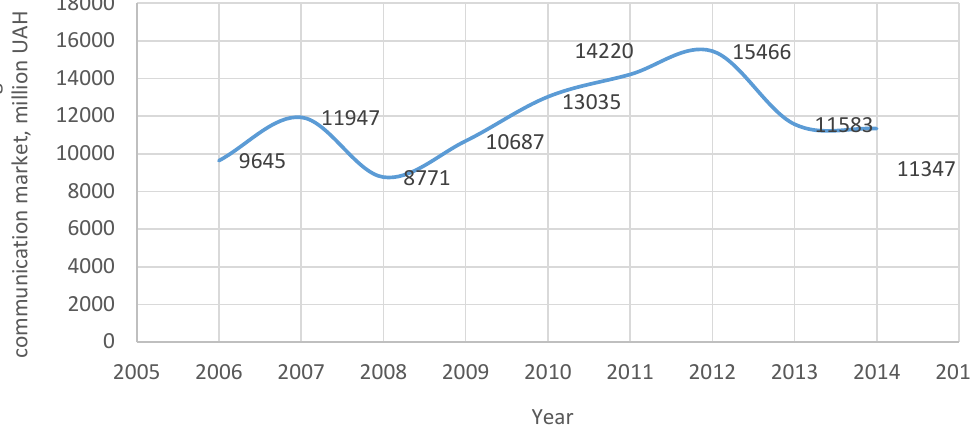
Figure 2. Dynamics of change of volume of the advertising and communication market of Ukraine during the period